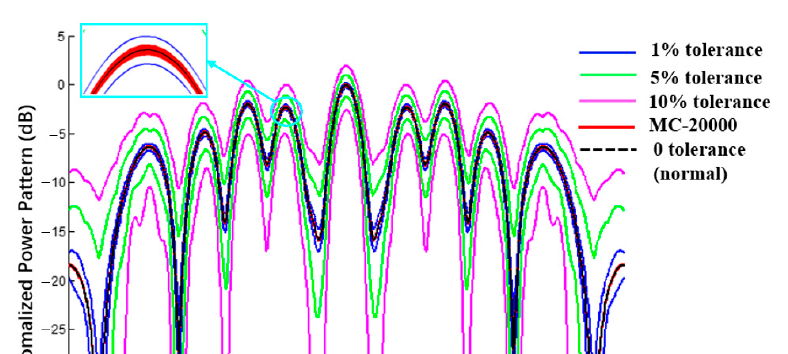
Table 3. Numerical results of power pattern in Figures 14 and 16.